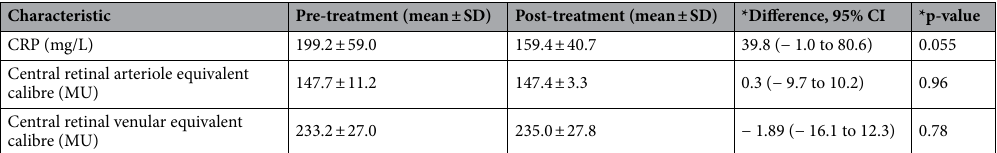
Table 5. Characteristics at recruitment and after treatment where initial and final CRP levels were both > 100 mg/L. CRP C-reactive protein. *Difference and P values are of paired results.